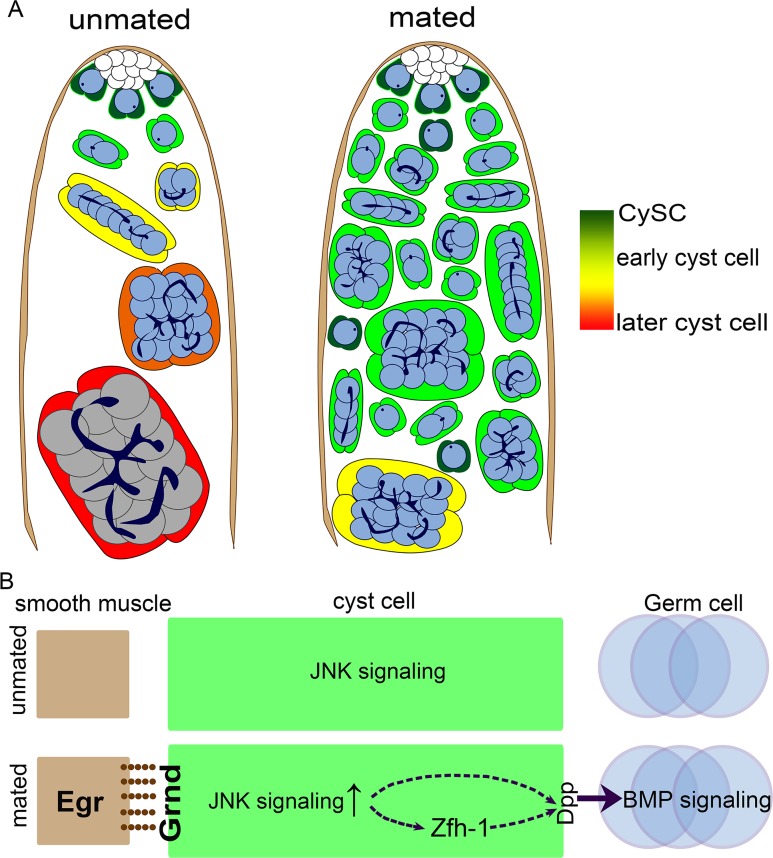
Summary and model of reproduction-induced accumulation of undifferentiated cells in the aged testes.(A) The schematic drawings of spermatogenesis in testes of unmated (left) and mated (right) aged males. Reproduction induces overproduction of CySC-like cells and early cyst cells due to extra cell divisions and blocked differentiation in aged males. Reproduction also leads to over-proliferation and accumulation of early germ cells at the expense of spermatocyte differentiation. (B) Models of reproduction-induced TNF-JNK signaling hyperactivation in regulation of spermatogenesis. In unmated testes (top), low-level JNK signaling is activated in cyst cells independent of Egr. In testes from mated males (bottom), Egr is accumulated abundantly in smooth muscles as early as 3w-old to act on induced TNFR Grnd. High-level JNK signaling activity induced by Egr up-regulates Zfh-1 expression and block differentiation in cyst lineage, that can be readily detected in testes from 5w-old males. Defect in germ cell differentiation is mediated by dpp-dependent BMP signaling activation.